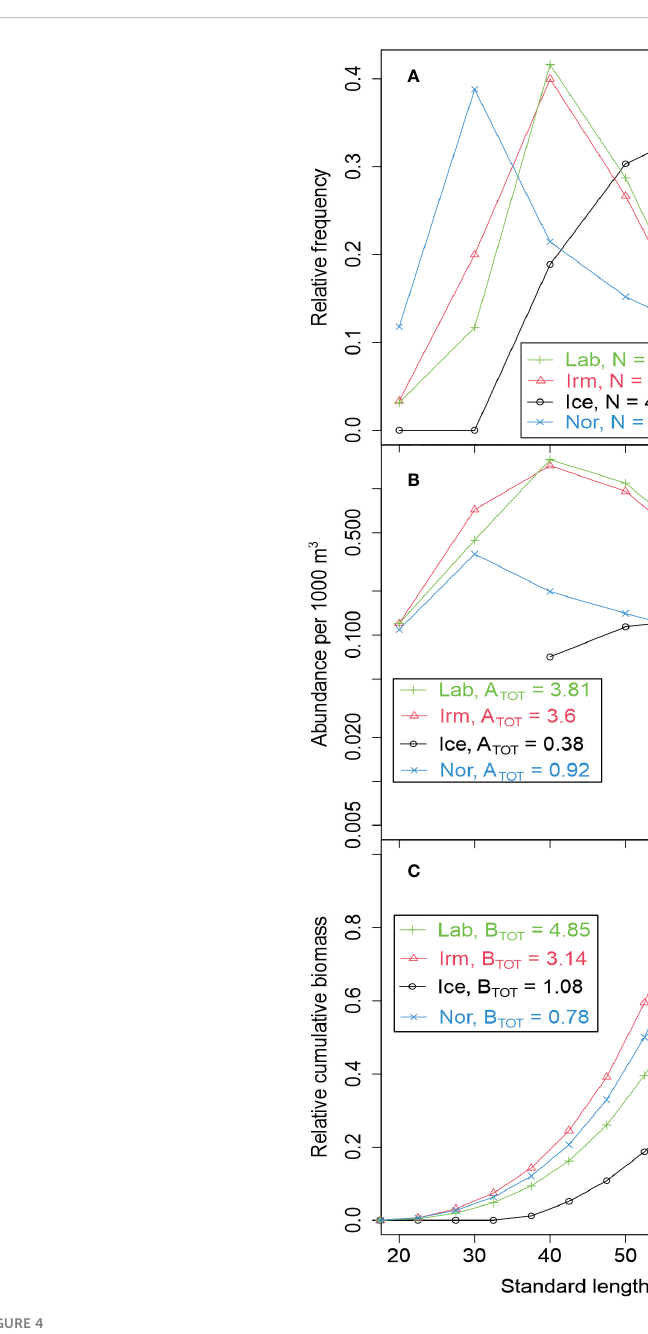
FIGURE 4 (A) Relative length distributions of B glaciale for each basin by length groups. N is the number fi sh measured for each basin. (B) Abundance in number of fi sh by length group per 1000 m 3 for each basin. A 3 (all length groups). (C) Cumulative biomass TOT is summed abundance of B glaciale per 1000 m versus standard length of B glaciale . B TOT is average biomass (g WW) per 1000 m 3 . Based on Macroplankton trawl catches (~1000-0 m) from the BASIN cruise (see Klevjer et al. (2020a) close to stations with trawls sampled for stomach contents (Table 1). Minor differences in total biomass levels